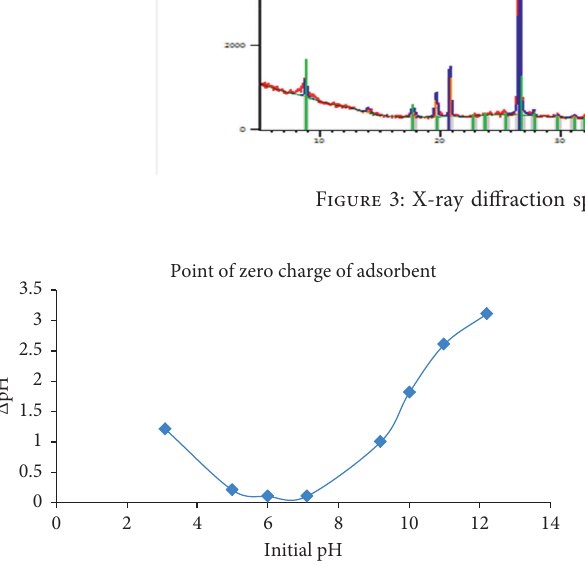
Figure 4: A graph of ∆ pH against initial